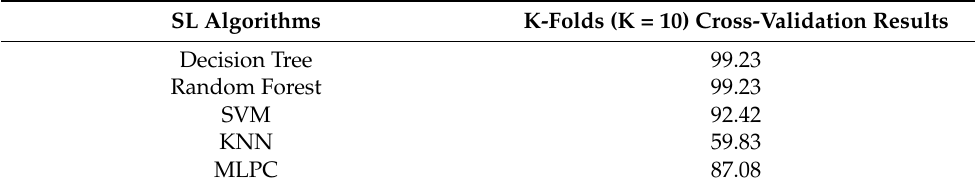
Table 3. Results of the accuracy in cross-validation stage for the first simulation (KPIs).